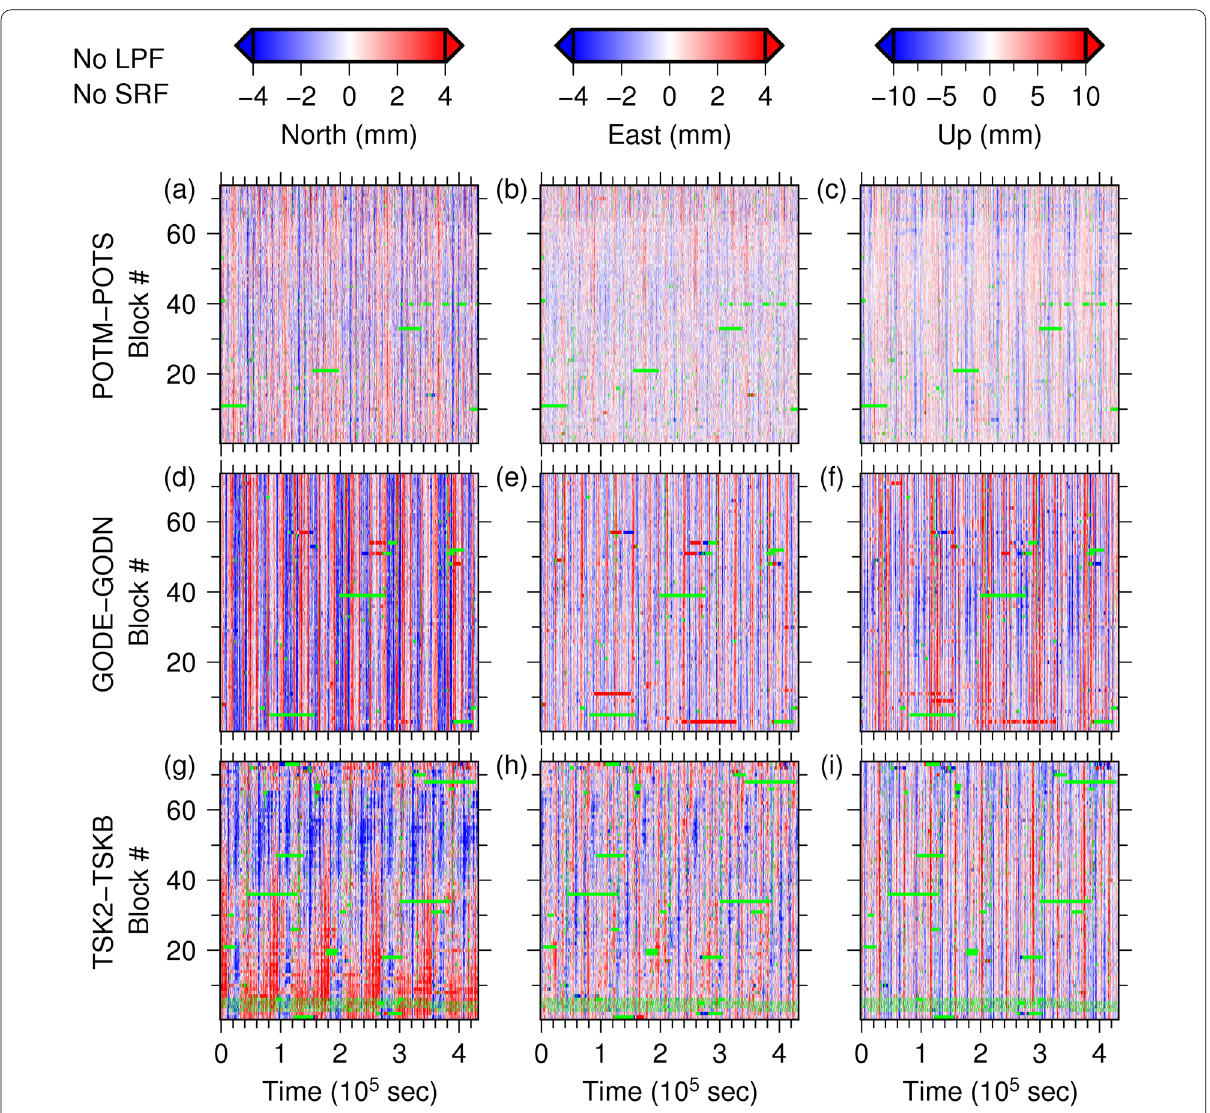
Fig. 3 Coordinate fluctuation of three baselines as labeled in each block. Left ( a , d , and g ), center ( b , e , and h ), and right ( c , f , and i ) columns indicate north, east, and up components, respectively. Neither low-pass filtering (LPF) nor sidereal filtering (SRF) is applied. Green color represents epochs filled by interpolation of neighboring epochs during the data cleaning process. The same plots but those after LPF are provided in Additional file 1: Figs. S5, S6, and